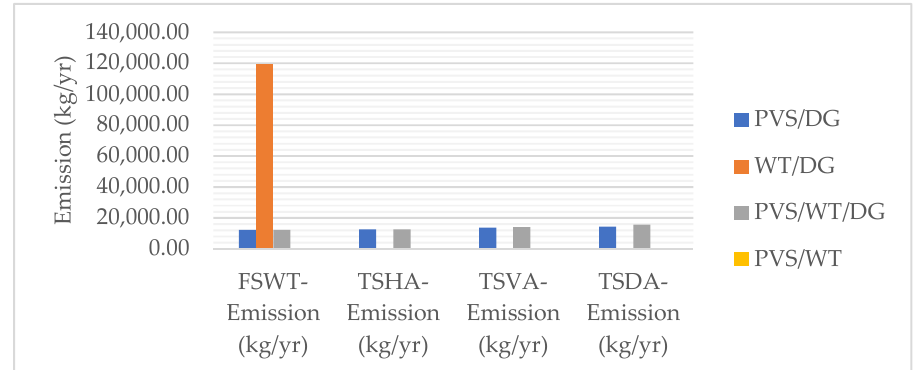
Figure 6. Total emission for different tracking systems in various configurations.